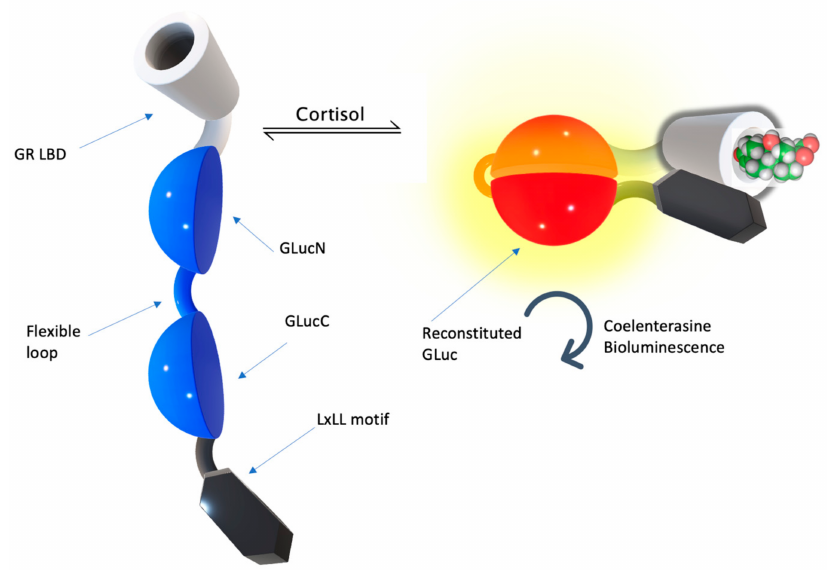
Figure 10. Intermolecular equilibrium binding of the split-luciferase cortisol fluorescent assay for in vitro cortisol monitoring. As cortisol appears and activates glucocorticoid LBD, which conforma- tionally changes toward enhanced affinity to the LxLL motif, allowing two luciferase domains to reconstitute its function and to report a cortisol concentration increase (Reproduced from [65] with permission from